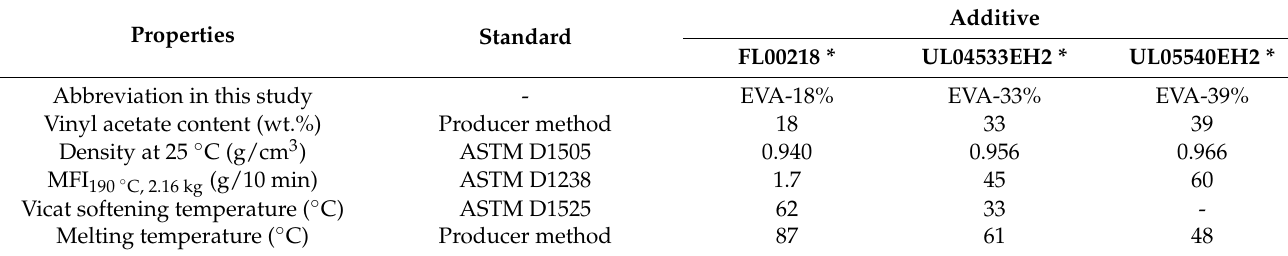
Table 1. Properties of the used EVA